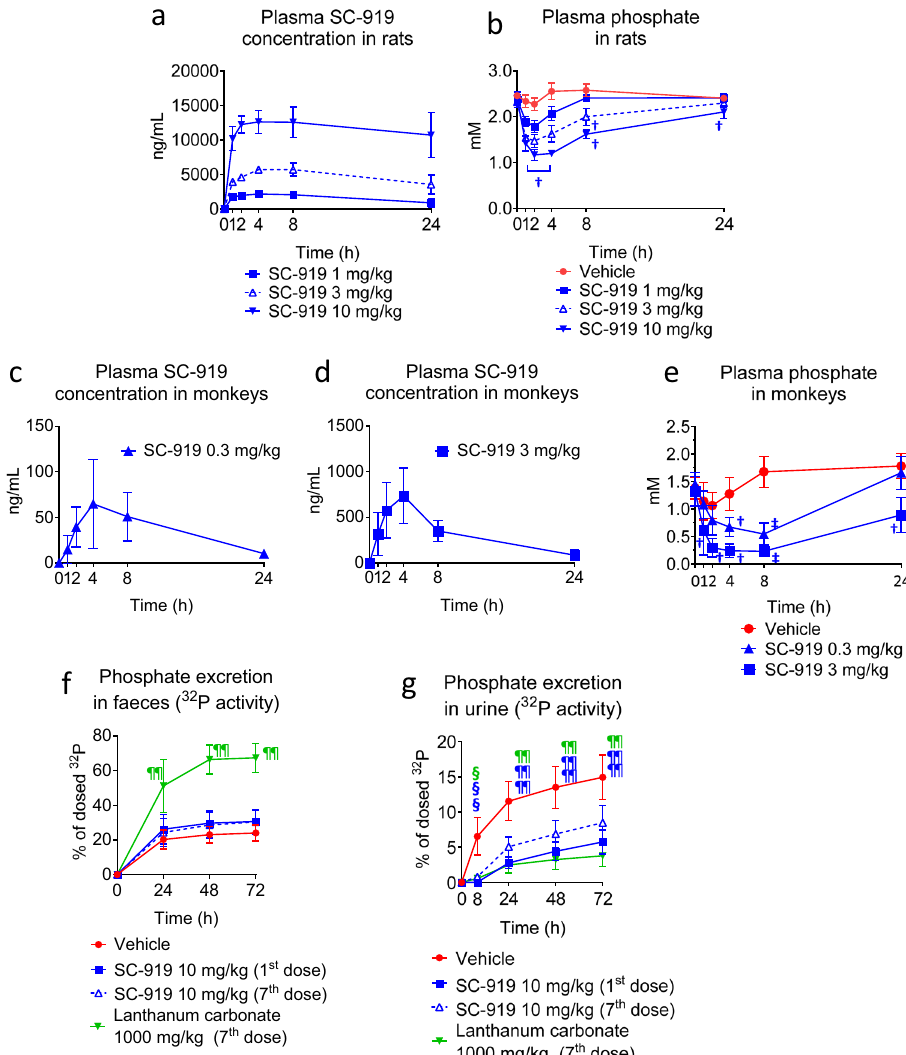
Fig. 3 IP6K inhibition decreases plasma phosphate levels in rats and monkeys and does not inhibit phosphate intake by the gut or phosphate reuptake by the kidney in rats. a Plasma concentration of SC-919 and b phosphate levels in normal rats administered SC-919. ( n = 3 biological replicates for pharmacokinetics and n = 5 biological replicates for the determination of plasma phosphate levels). c, d Concentration of SC-919 and e phosphate levels in the plasma of normal monkeys administered SC-919. ( n = 6 biological replicates). f Effect of SC-919 on the cumulative 32 P activity in the faeces of rats that were administered NaH 2 32 PO 4 solution. ( n = 5 biological replicates). g Effect of SC-919 on the cumulative 32 P activity in the urine of rats that were administered NaH 2 32 PO 4 solution. ( n = 5 biological replicates). Values indicate mean ± S.D. † P < 0.05 and ‡ P < 0.05 vs. vehicle as determined using Williams ’ test and Shirley – Williams test, respectively. ¶¶ P < 0.01 and § P < 0.05 vs. vehicle as determined using Dunnett ’ s test and Steel test,